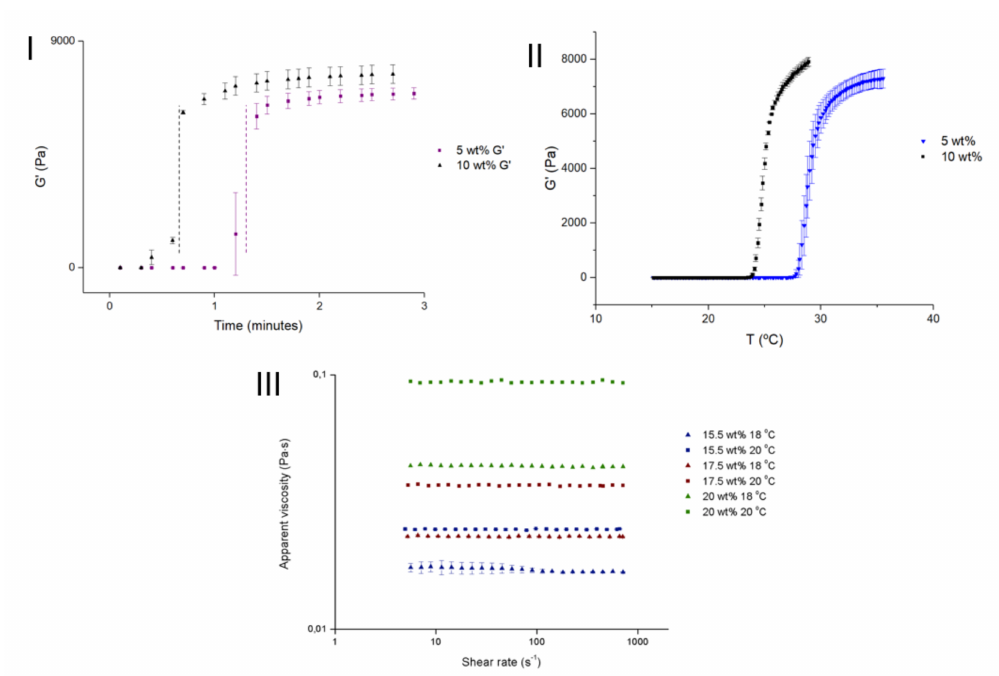
Figure 4. ( I ) Transient dynamic test with different particle concentrations; ( II ) temperature sweep in a dynamic test of a microparticles in hydrogel system with different particle concentrations; ( III ) flow curve of a microparticles in hydrogel system with different particle concentrations and at different temperatures. (Adapted with permission from [11]. Copyright (2021)